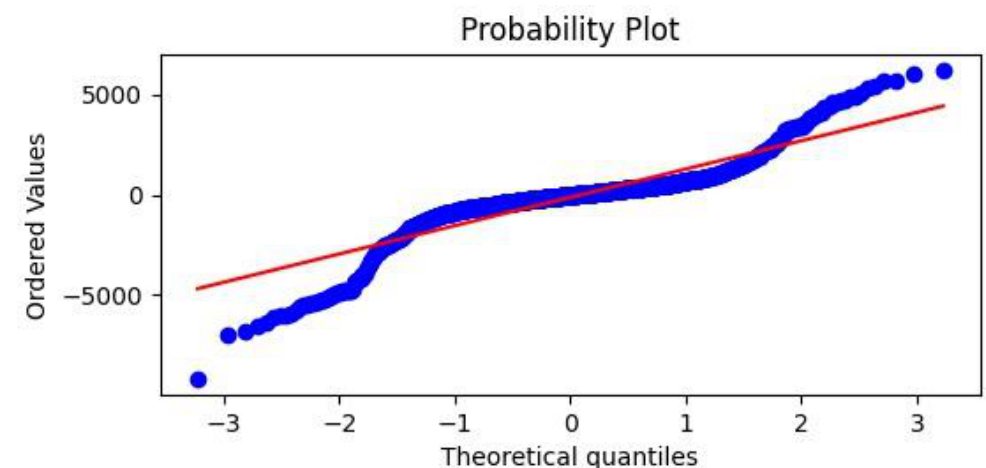
Figure 10. A Q–Q (quantile–quantile) plot resulting from the validation process of V-MLP-2. Figure 10. A Q – Q (quantile – quantile) plot resulting from the validation process of V-MLP-2.